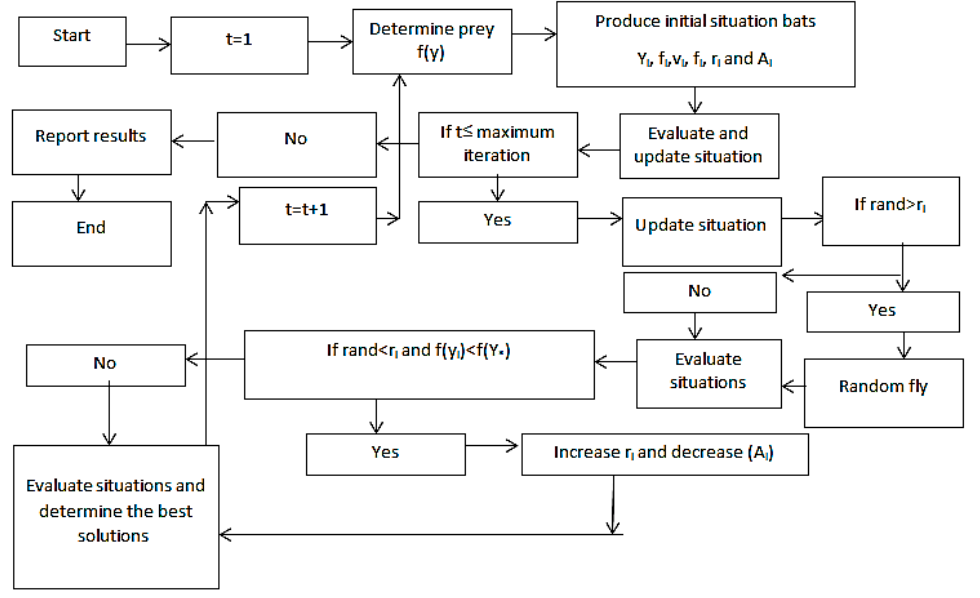
Figure 2. The flow chart of the bat algorithm.